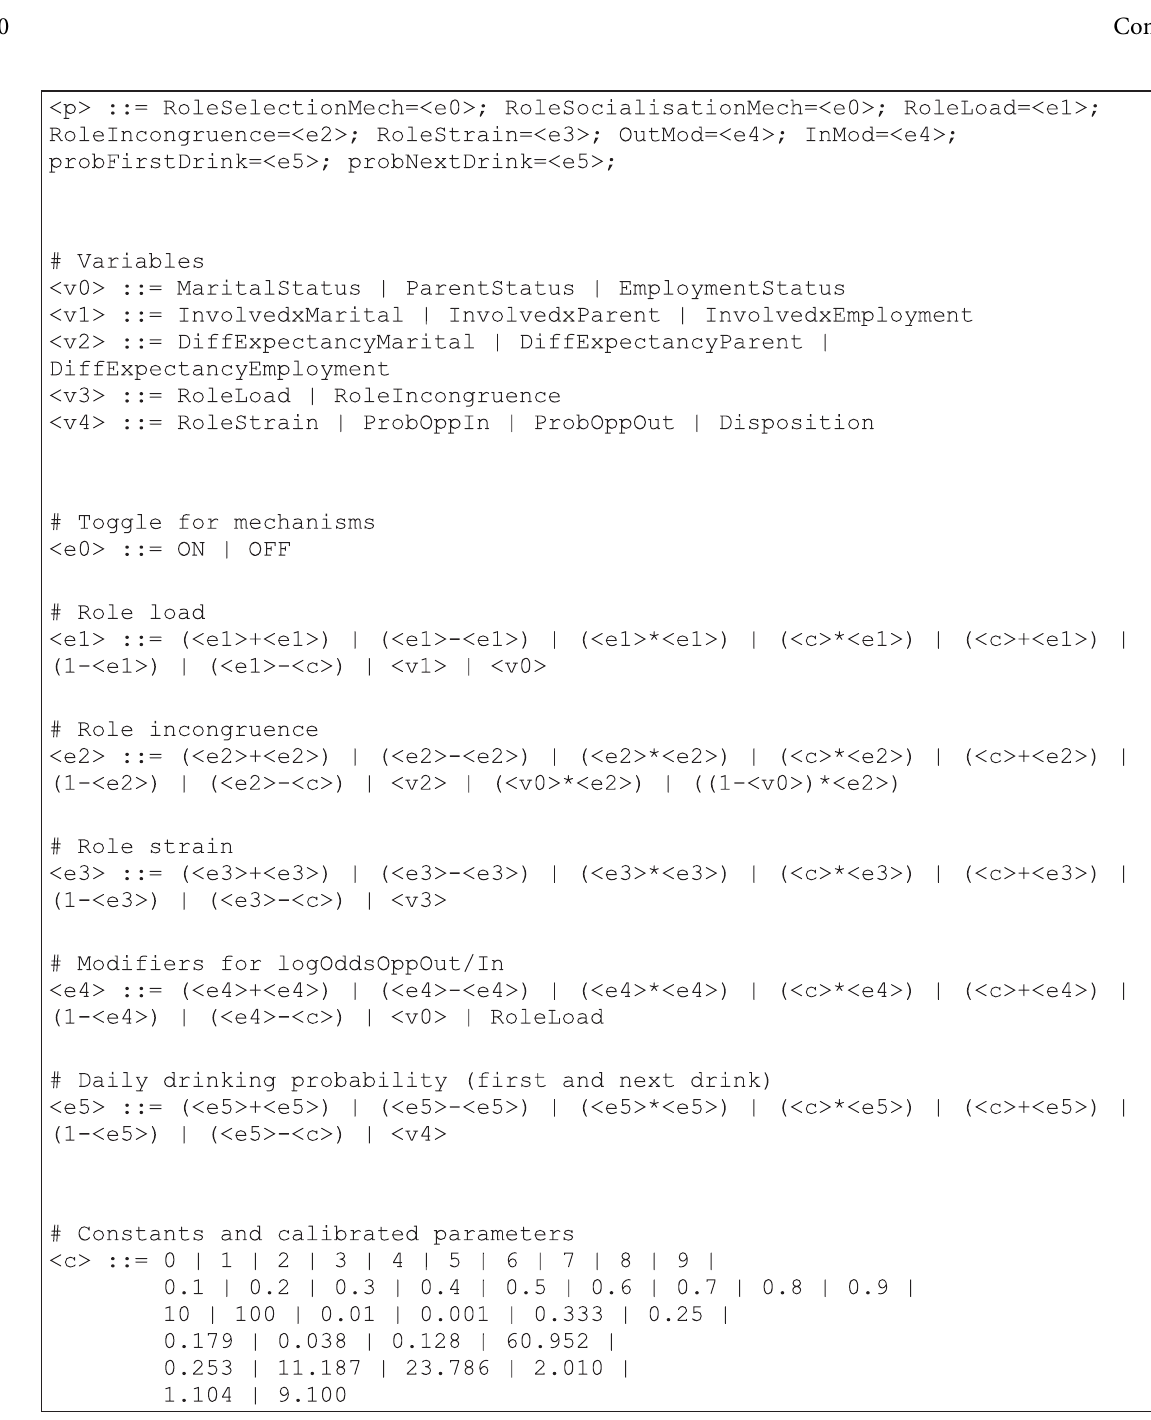
Figure 4: Context-free grammar. Variables have the same name as in Table 1 but, for improved clarity, without the indexing notation. Shorthand notation is defined for the multiplication of role involvement